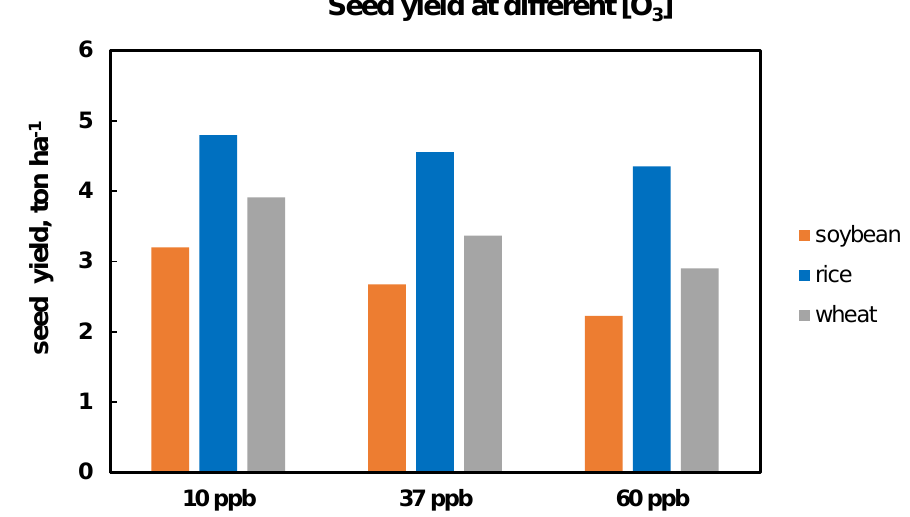
Figure 6. Estimation of the typical seed yield (SY) based on FAO statistics for global average yields and the response functions of the present study for three O 3 concentration scenarios: preindustrial O 3 (10 ppb), the average O 3 levels of the control treatments in the experiments (37 ppb), and a hypothetical future increased [O 3 ] at 60 ppb.